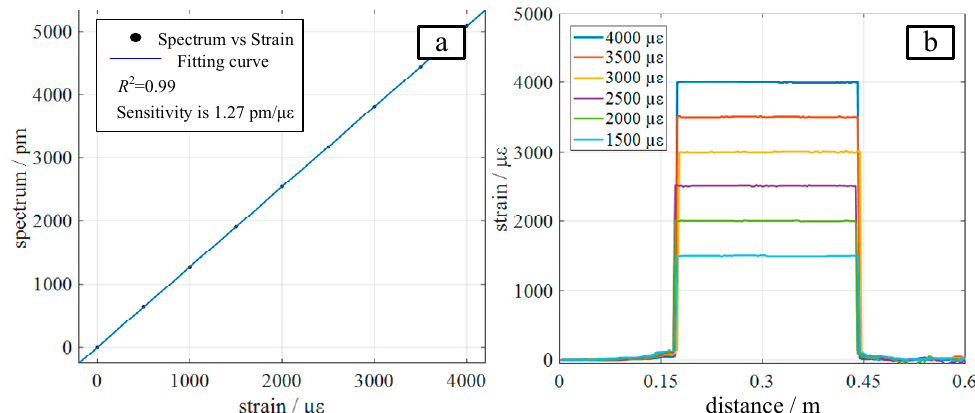
Figure 9. Distributed strain measurement results: ( a ) shows the fitting curve of strain and spectral shift, which maintain a highly linear relationship, and ( b ) shows the distributed strain demodulation result of the proposed method.